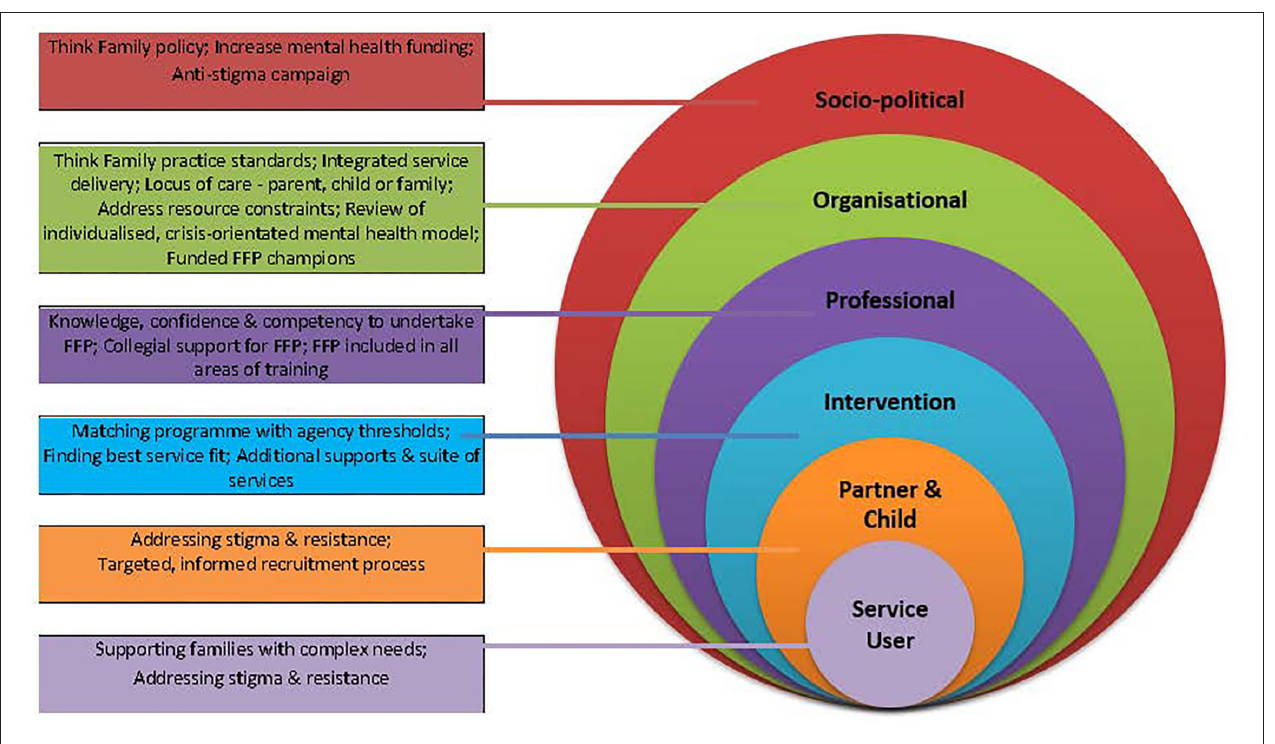
FIGURE 2 | Multi-level approach to embed